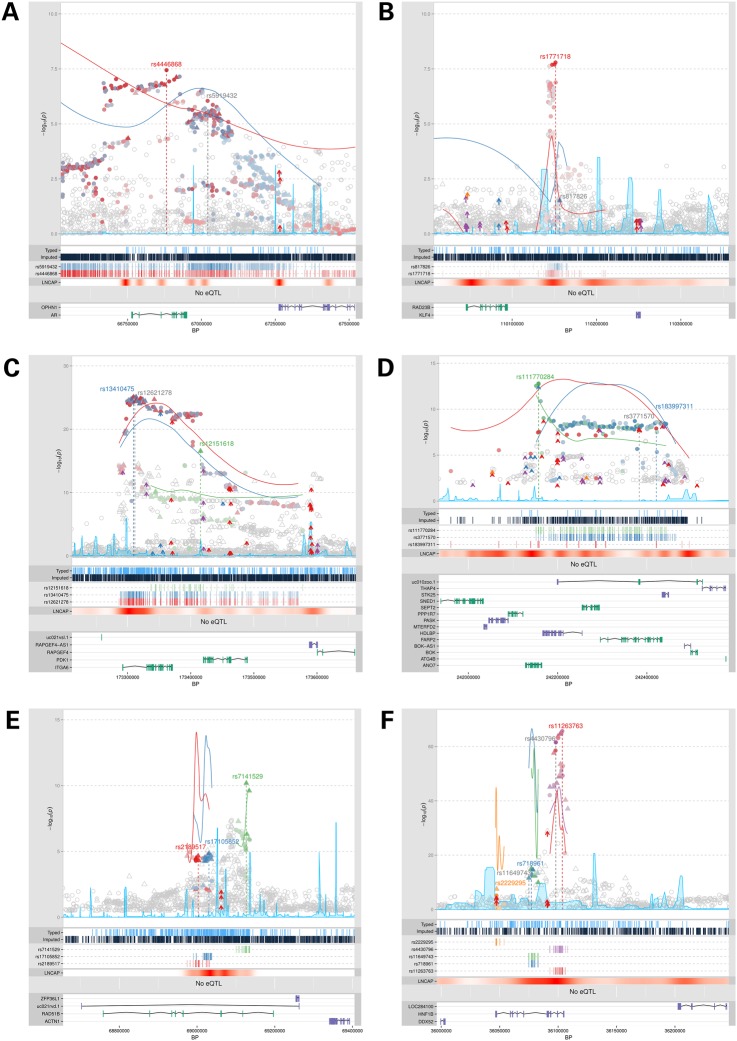
Locus explorer plots of two simple and four complex regions. (A) Region 23_3 at ChrXq12, (B) Region 9_1 at Chr9q31, (C) Region 2_6 at Chr2q31, (D) Region 2_8 at Chr2q37, (E) Region 14_2 at Chr14q24 and (F) Region 17_2 at Chr17q12. For regions containing multiple independent association signals, the separate lead SNPs are indicated and colored red, blue, green, orange and purple, respectively. Original GWAS tag SNPs that were replaced during fine-mapping are marked in gray on the plot. Clusters of correlated variants for each signal are distinguished using different colors in the plot and on the panel below, including for the original GWAS SNPs. Stronger shading indicates greater correlation with the lead SNP, with variants not correlated at r2 ≥ 0.5 with any lead SNP uncolored. Directly genotyped variants are denoted as triangles and imputed variants as circles. Log10
P-values are shown on the Y-axis of the plot. Colored arrows within the plot mark SNPs that overlap with regulatory elements in ENCODE; red for 3′UTRs, blue for coding variants, purple for promoters and orange for miRNA sites. The position of genes within the region and the genomic coordinates of the plot are shown on the lower panel, with genes on the positive strand in green and the negative strand in purple. The LNCaP track shows the density of annotated bio-features within the LNCaP cell-line (data from ENCODE).